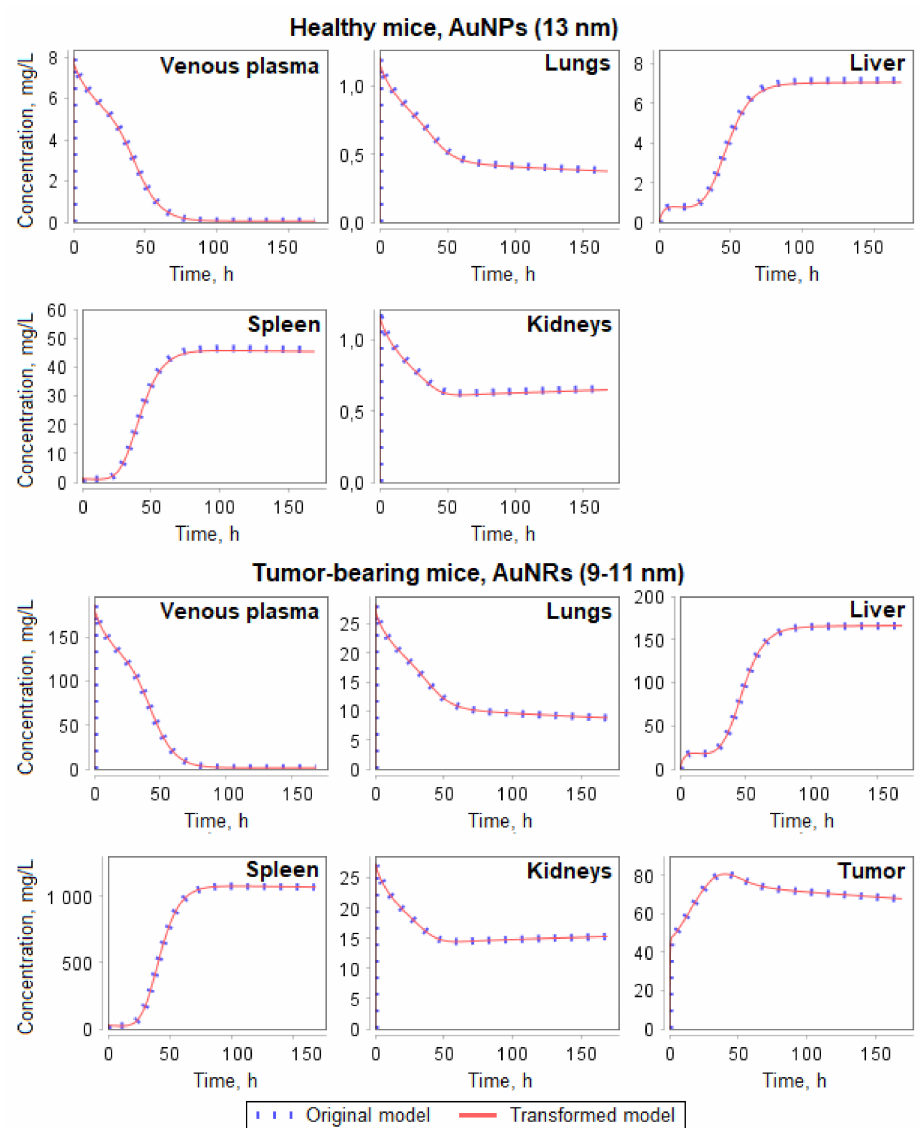
Figure 11. Simulation results of temporal changes in the concentration of the gold nanoparticles (AuNPs, 13 nm) in healthy mice and of the gold nanorods (AuNRs, 9–11 nm) in tumor-bearing mice, obtained for venous plasma, as well as lung, liver, spleen, kidney, and tumor